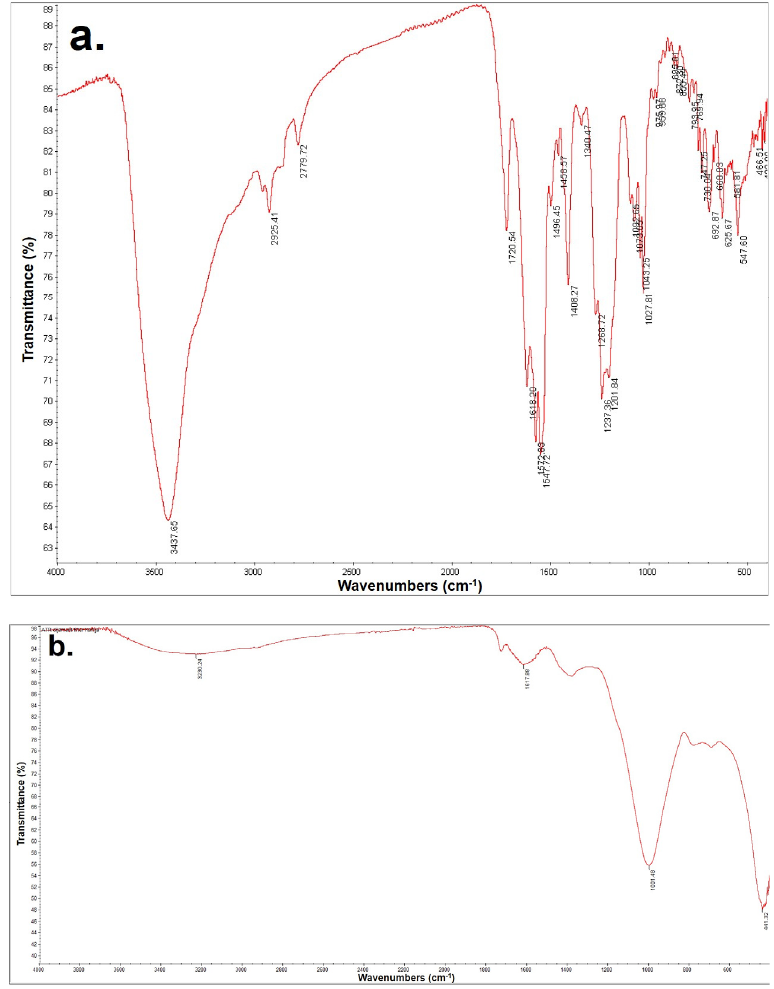
Figure 7. FTIR spectra of the ( a ) RB4 solution before treatment, ( b ) RB4 effluent after treatment. For the dye RB4, the initial effluent indicated the presence of the expected groups, such as groups with double bonds, primarily carbonyl groups with oscillation at 1720 cm − 1 with oscillation type ν (C=O), and different aromatic structures with halogen atoms (in this case it is Cl) with the frequency of the absorption band at 680–725 and 750–810 cm − 1 δ (CH) out of the plane, such as the aromatic ring frequency at 1450 ± 10 cm − 1 with the ν (C=C) and ν (C-C) skeletal types of oscillations. Amino groups with aryl residues in the frequency range 1280–1350 cm − 1 , ν (C-N), as well as aromatics containing nitrogen in the structure (pyridine-type structure) with a frequency of 1200–1300 cm − 1 ν (N-O) were also identified [39]. After the treatment, the recorded spectra showed significantly lower frequency maxima, which indicated the mineralization of the solution as well as the degradation that took place in the direction of creating smaller molecules and reducing aromatic structures. Peaks in the range of 1000–3300 cm − 1 are attributed to vibrations of O-H bond stretching in carboxylic acid molecules. The second maximum at 1617 cm − 1 corresponds to the tensile vibrations of the C=C bond of the polyphenolic components. The maximum at 1031 cm − 1 indicated the presence of C-C tensile vibrations, as well as C=C, C-O-C, and O-H vibrations. The maximum at 441 cm − 1 is attributed to -S-S- tensile vibrations. The identified peaks of characteristic functional groups were been confirmed by the author in